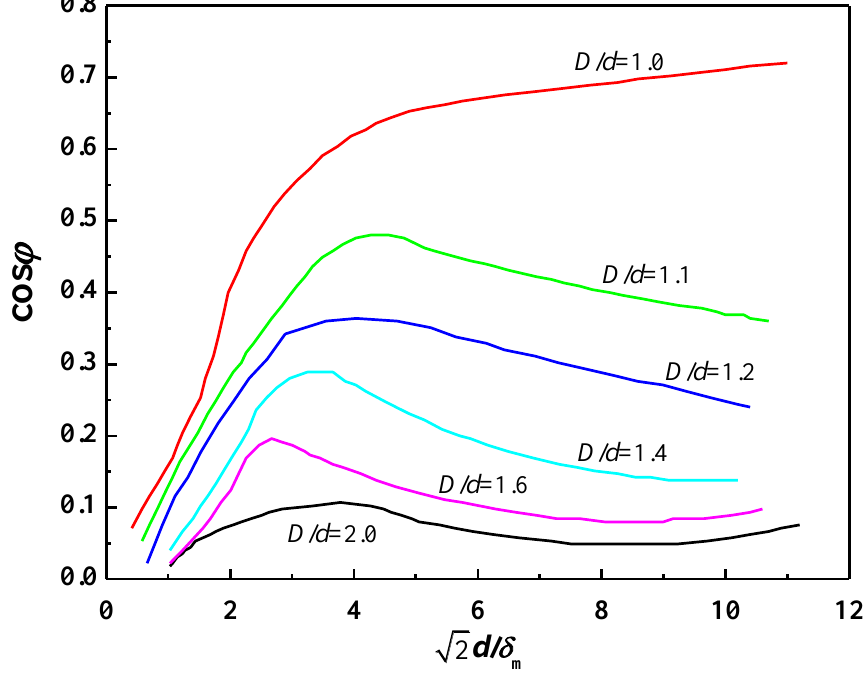
Figure 4. Power factor of the medium-frequency induction furnace under induction heating of infinite cylinder.